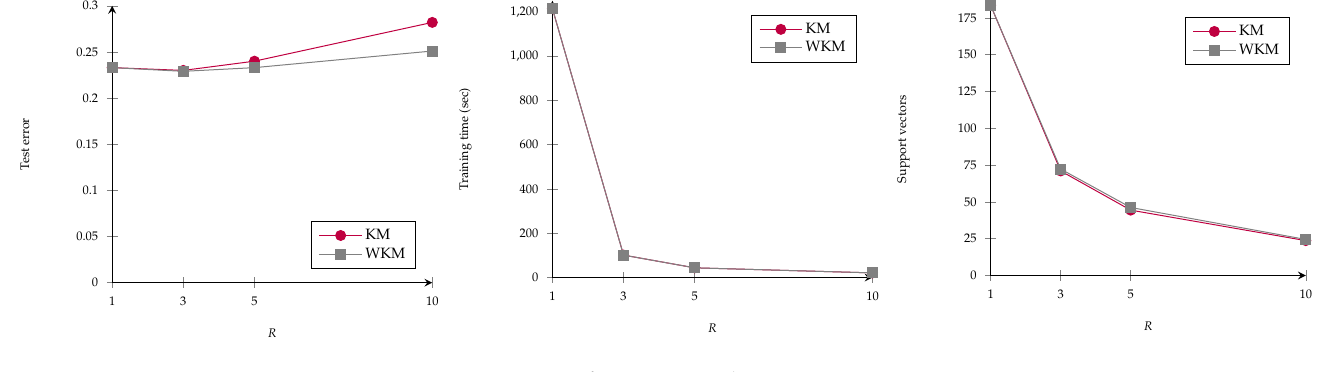
Figure 13. Comparison of KM-SVM and